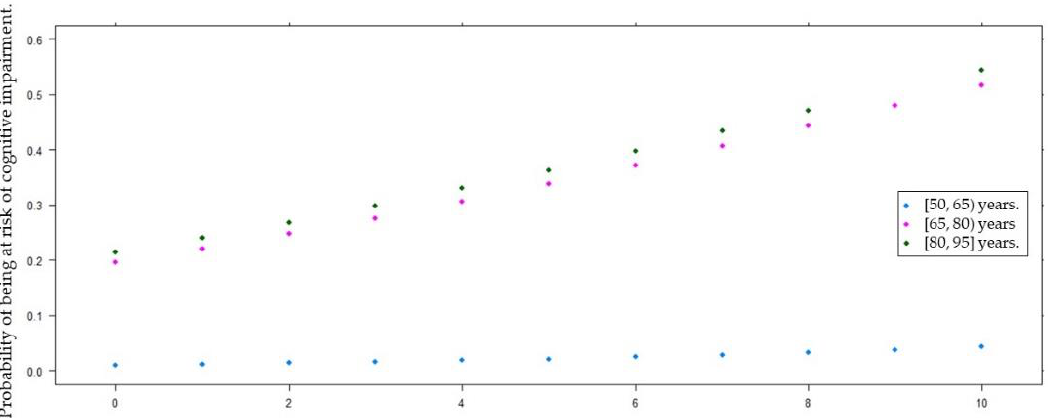
Figure 2. Estimated probability of being at risk of cognitive impairment based on ( A ) purpose in life; ( B ) engagement with life; ( C ) resilience; or ( D ) dependent chronic pain, adjusted by age groups.